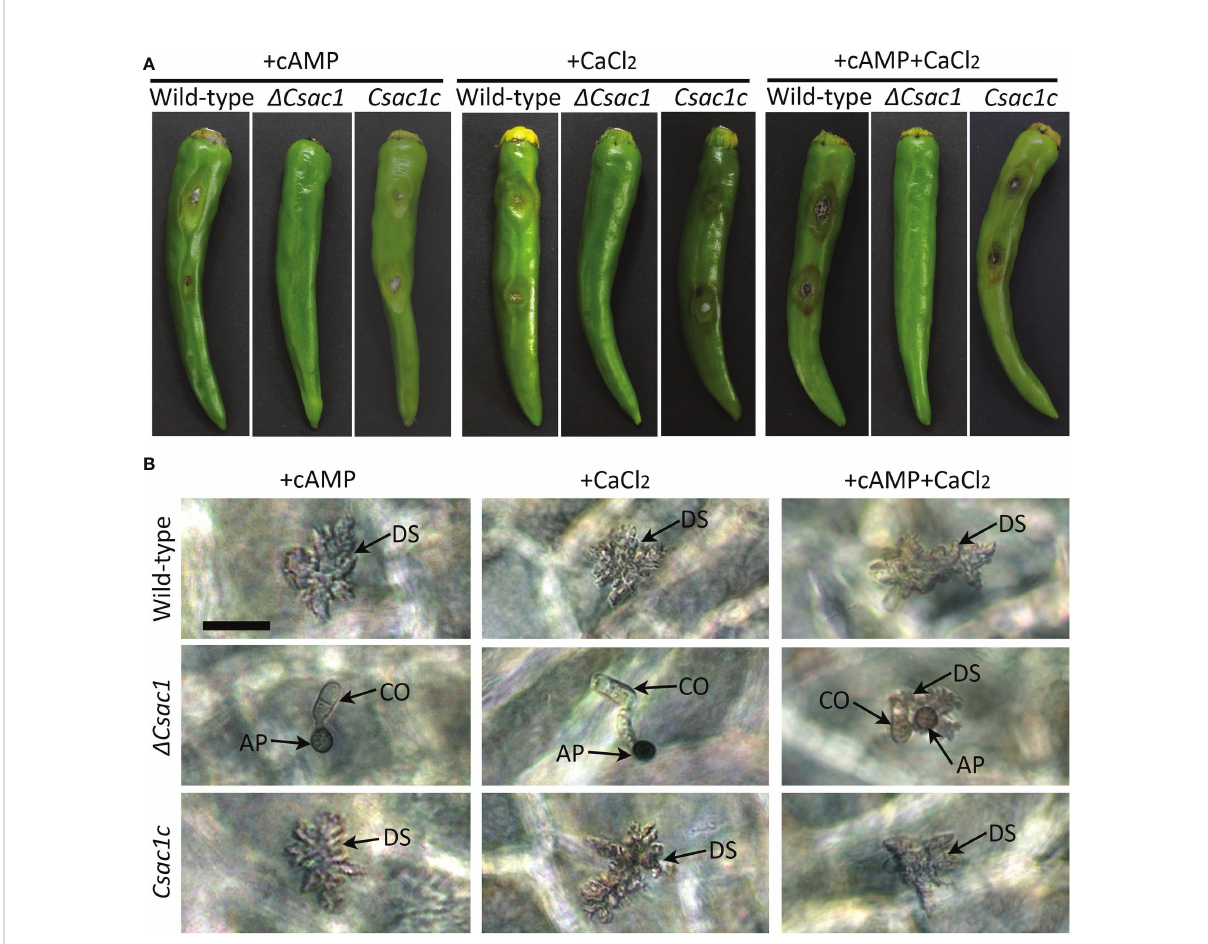
FIGURE 8 Recovery of appressorium-mediated penetration of D Csac1 by exogenous cAMP and CaCl 2 . (A) Pathogenicity of D Csac1 . Intact and wounded pepper fruits were inoculated with conidial suspensions (50 × 10 4 /mL) and incubated in a humid plastic box. After 24 hours, 2.5 mM cAMP, 15 µM CaCl 2 , and 2.5 mM cAMP and 15 µM CaCl 2 were added to conidial drops. Photographs were taken after 9 days. (B) Microscopic observation of penetration by D Csac1 . Conidial suspensions (5 × 10 4 /mL) were dropped onto pepper fruits and incubated in a humid plastic box. After 24 hours, 2.5 mM cAMP, 15 µM CaCl 2 , and 2.5 mM cAMP and 15 µM CaCl 2 were added. Photographs were taken after 3 days. Scale bar, 20 m